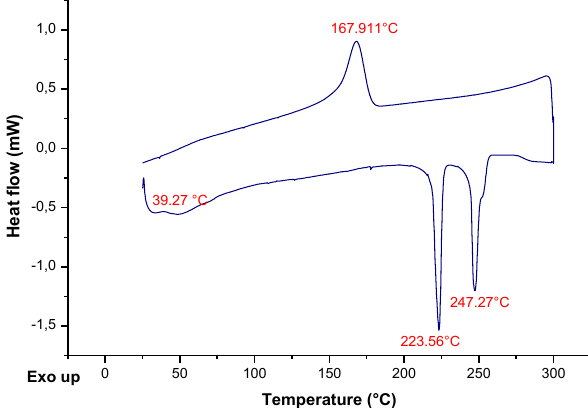
Figure 5. Di ff erential scanning calorimetry (DSC) spectrum of bicomponent Figure 5. Differential scanning calorimetry (DSC) spectrum of bicomponent filaments.